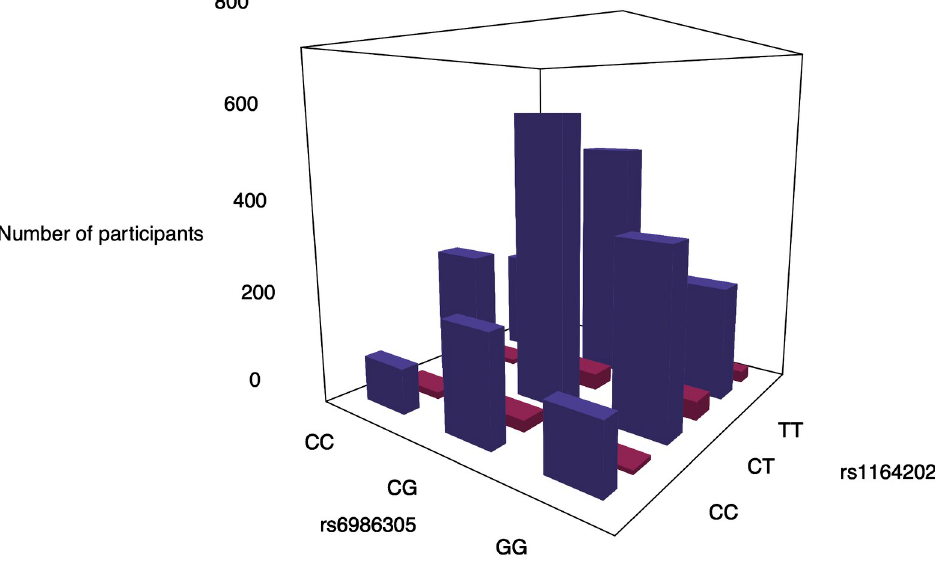
Fig 7. Genotype combinations between rs6986305 and rs11642027 for the participates with venous thrombosis or pulmonary embolism under main effect filtering. The genotypes of each SNPs were plotted with the number of the participants with venous thrombosis or pulmonary embolism (cases: red) or not (controls: purple).